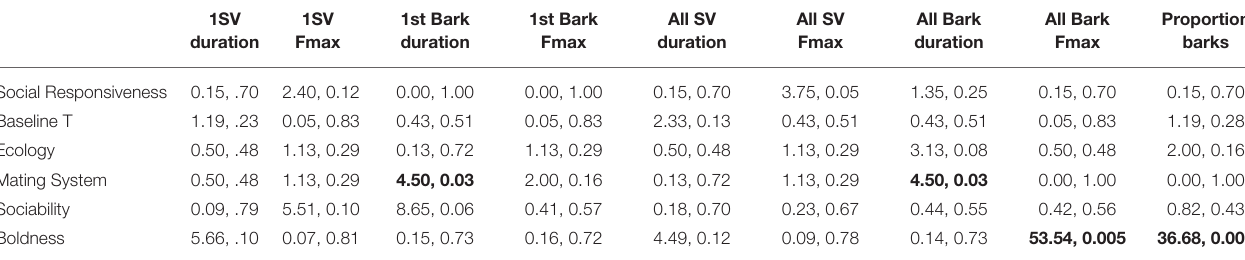
TABLE 3 | Test statistics and p- values for all comparisons of predictors and USV